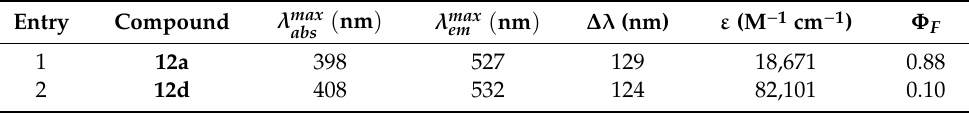
Table 1. Photophysical properties of the 12a,d measured in acetonitrile.